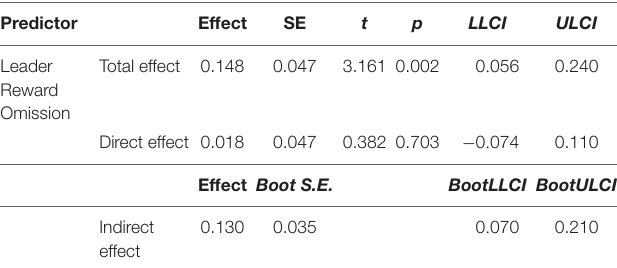
TABLE 4 | Results of bootstrapping tests with 95% confidence intervals (CI): the mediating roles of moral disengagement between leader reward omission and deviant